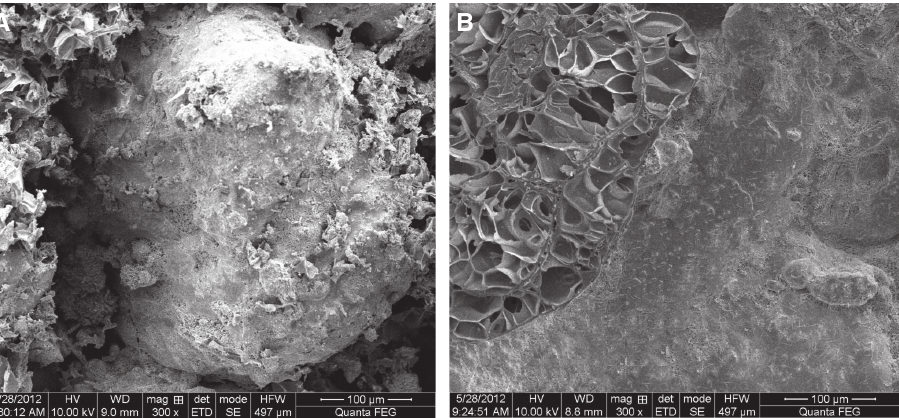
Figure 6 Micromorphology on the section of samples A0 and S3. (A) Sample A0. (B) Sample